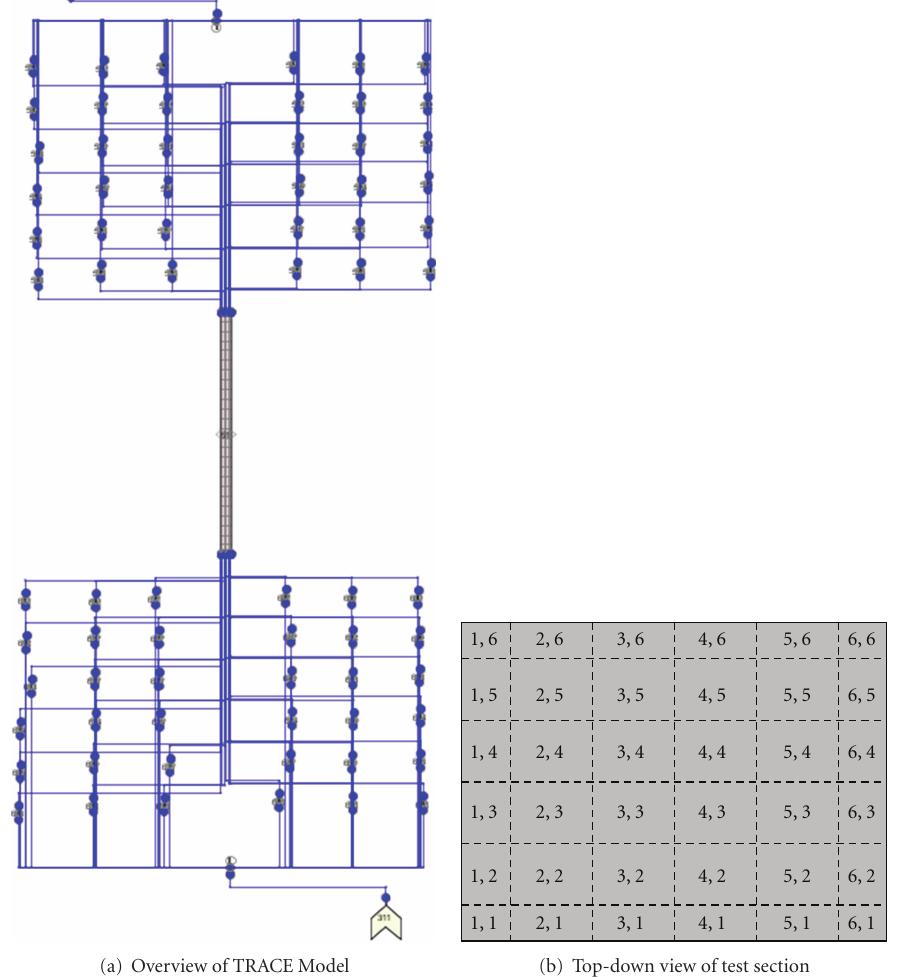
Figure 12: Nodalization for TRACE.